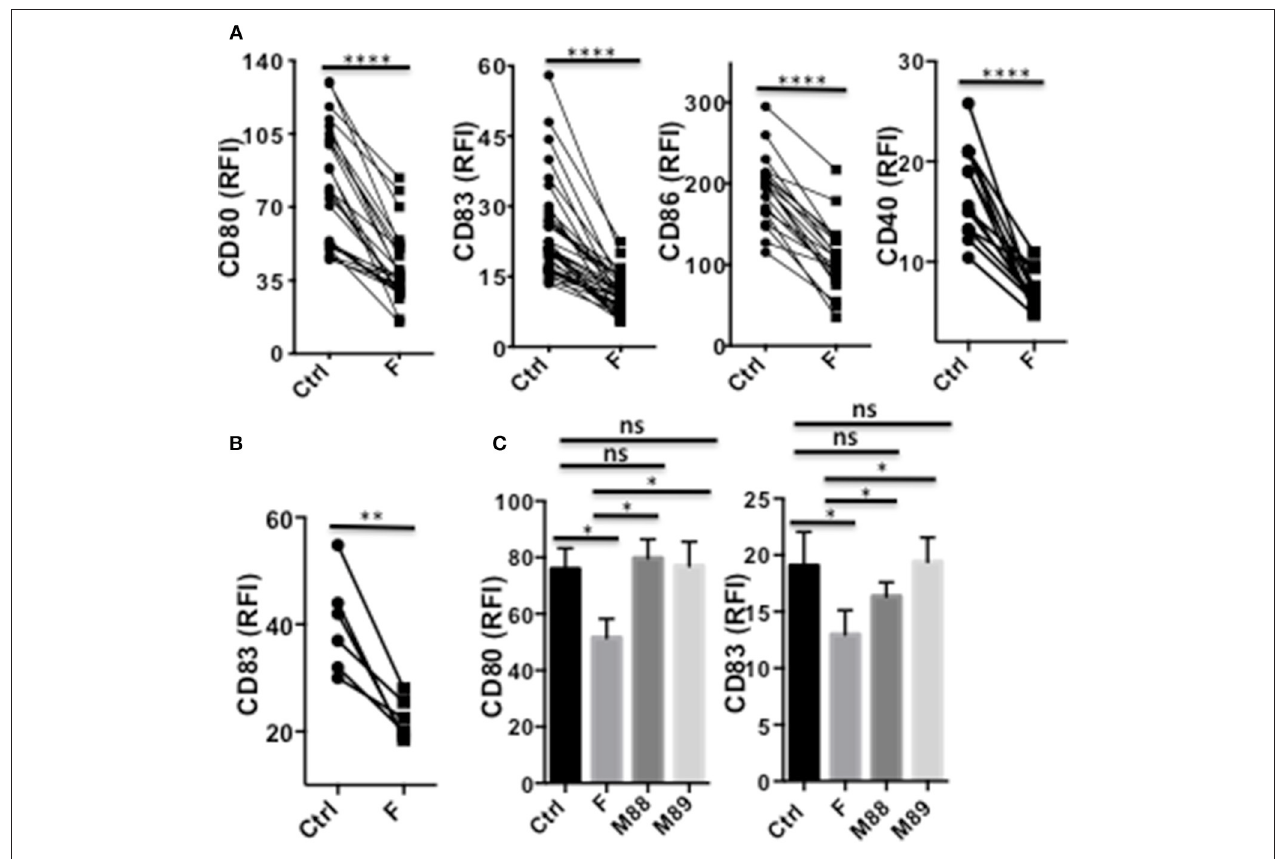
FIGURE 3 | A single exposure to F. prausnitzii inhibits DC maturation. (A) Expression of CD80, CD83, CD86 or CD40 by DC exposed or not to F. prausnitzii at the beginning of their differentiation or (B) at day 5 of their differentiation ( n = 6), and stimulated by LPS at day 6 during 48h; (C) Expression of CD80 or CD83 ( n = 7) by bacteria-exposed DC. Marker expression was measured by flow cytometry using a Canto II FACS Scan and expressed as relative fluorescence intensity (RFI) ± sem. Paired t -test. * p < 0.05, ** p < 0.005, **** p < 0.00005.